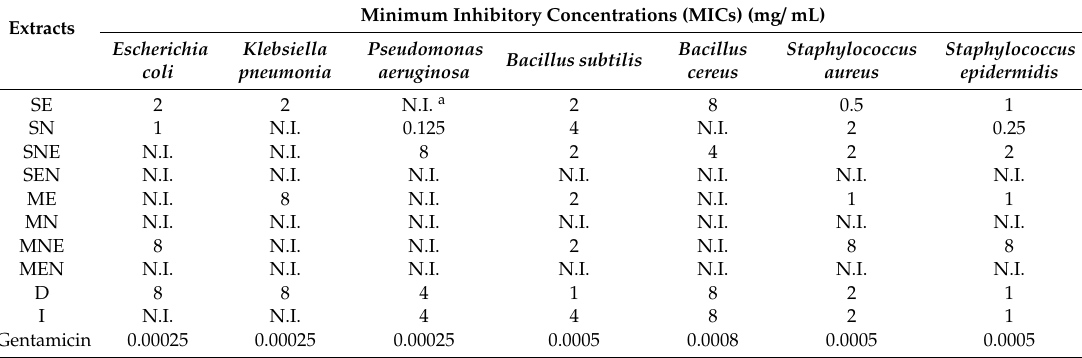
Table 2. Antibacterial activities of TS extracts expressed as minimum inhibitory concentrations (MICs).